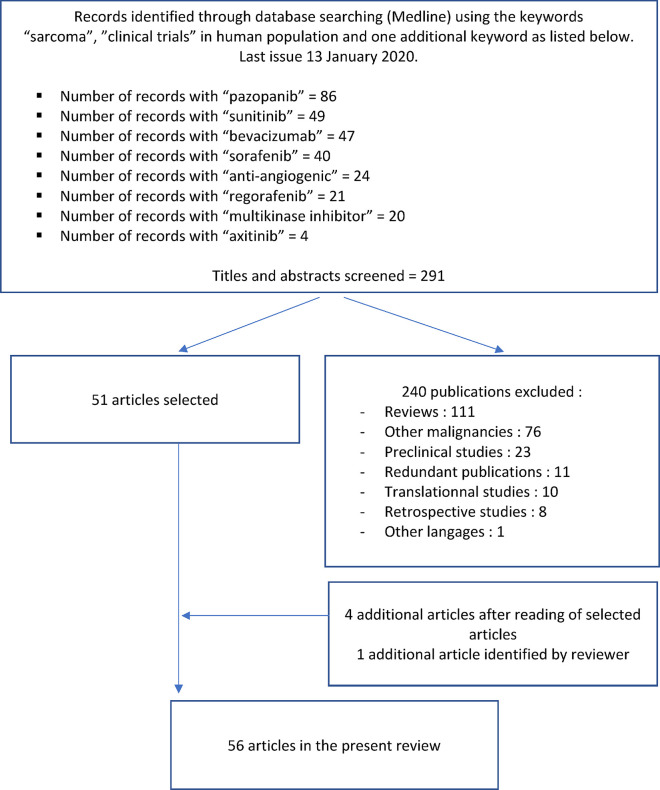
Search strategy.